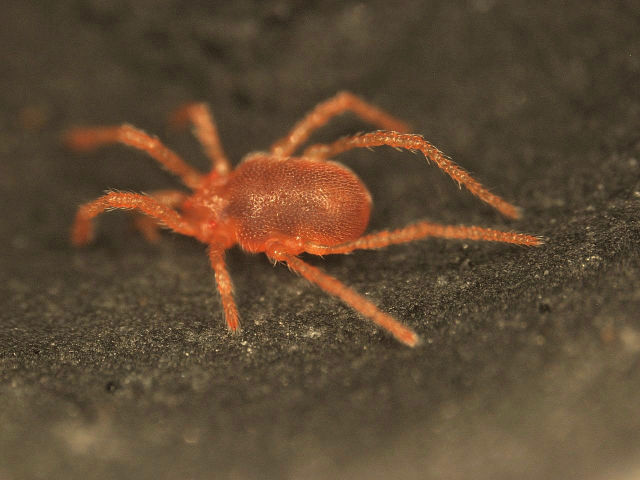
Johnstoniana sp. Photo Joanna Mąkol.